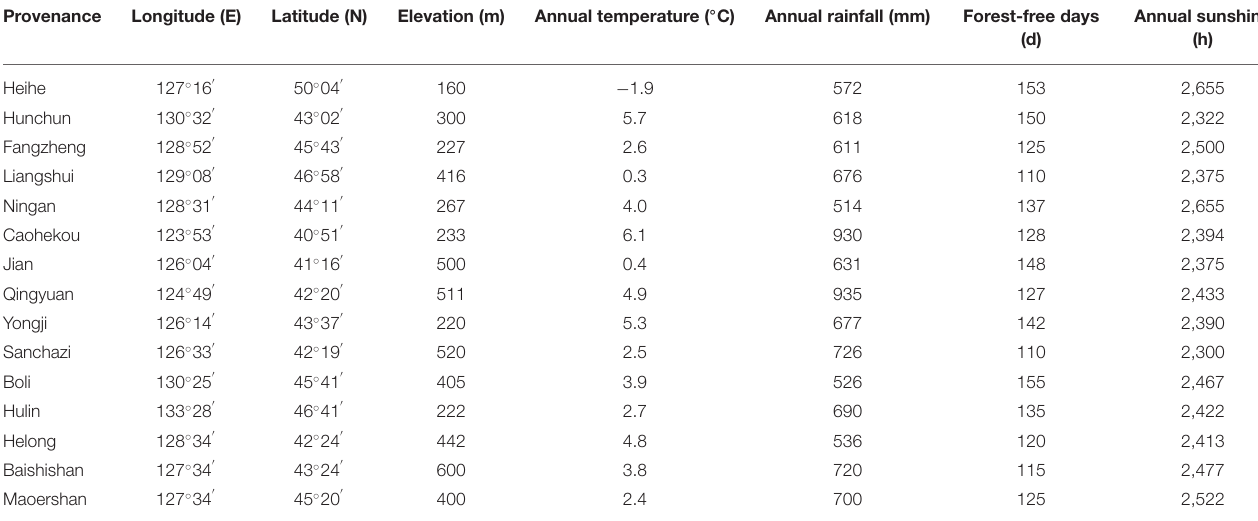
TABLE 1 | Summary of J. mandshurica sampling locations in Northeast China.